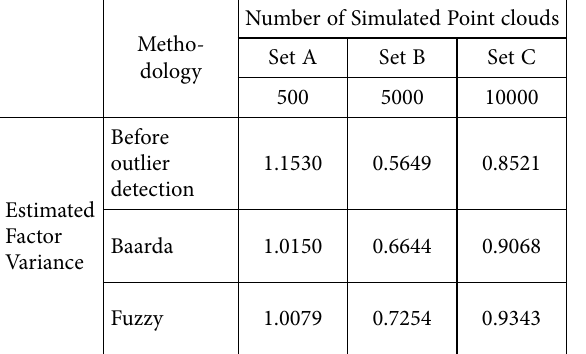
Table 4. Comparison of Baarda method and Fuzzy approach to detect outliers for randomly simulated 3D point clouds